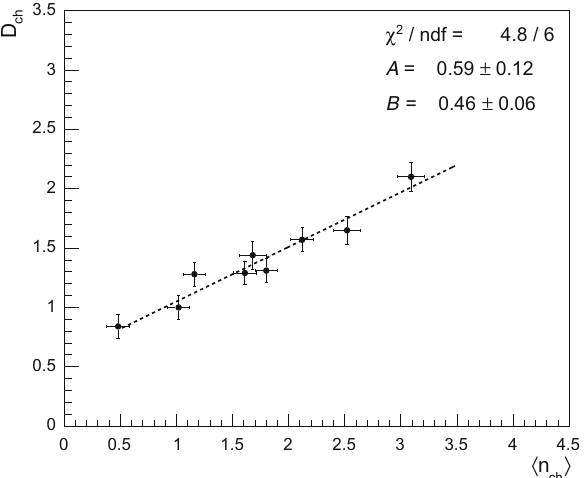
Fig. 10 KNO scaling distribution. The curve superposed on the data results from a fit using the parameterisation defined in Eq. 7 scaling to low energies. In the current analysis, this implies that α = − A / B = − 1 . 28 .